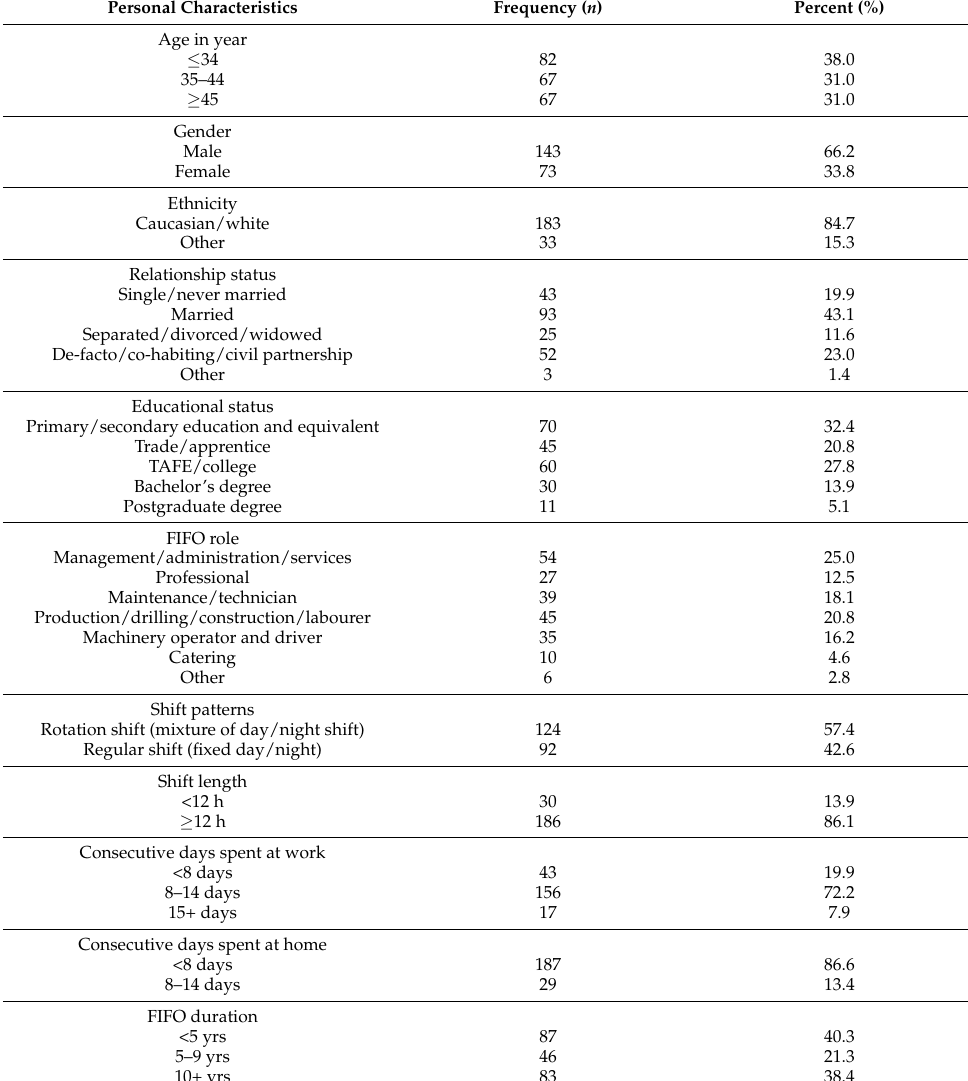
Table 2. Distribution of demographics and work-related characteristics of FIFO workers ( N =